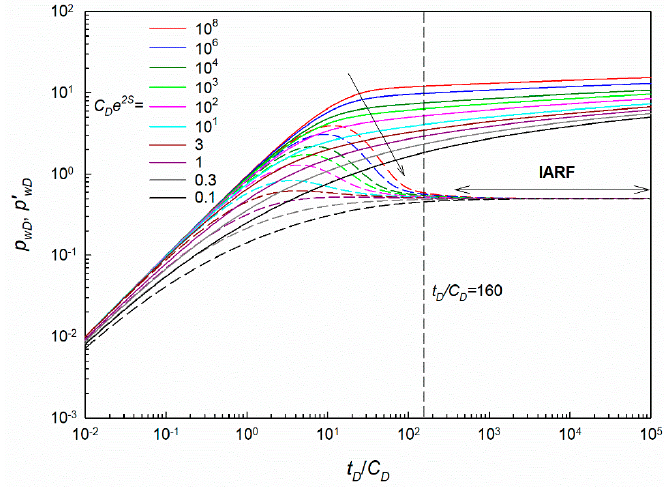
Figure 4. G-B type curves with different values of C D e 2S .